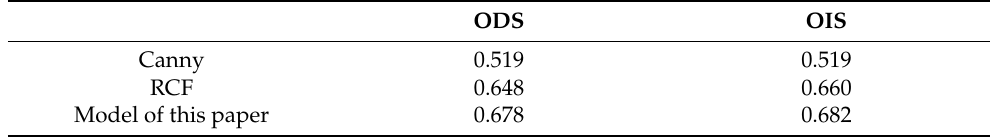
Table 1. The model is compared with the RCF results.